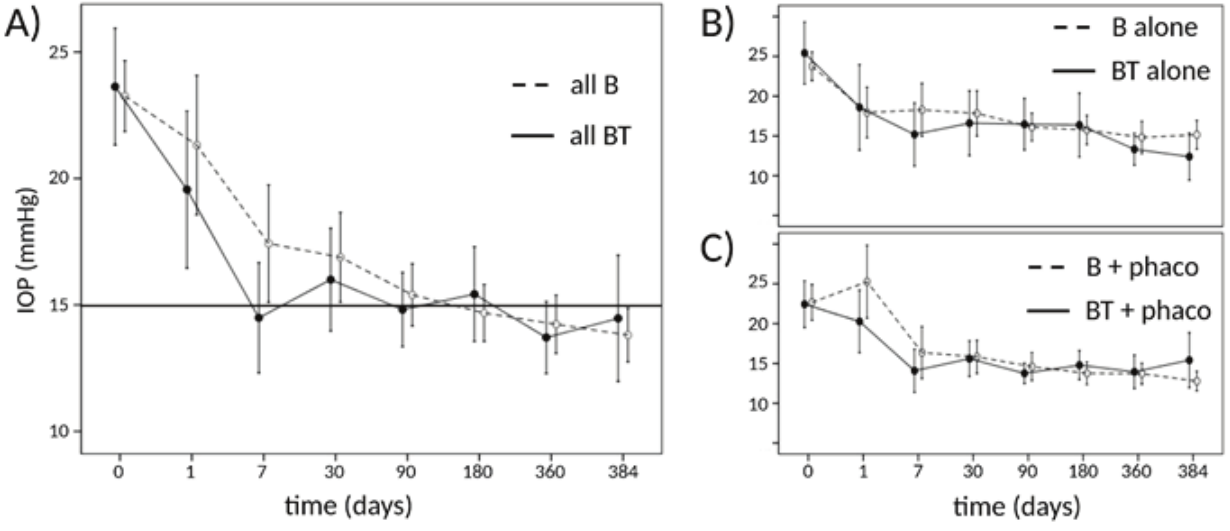
Figure 2. IOP in the B and BT groups. (A) IOP in the BT group was similar to the B group and trended toward a lower average although tubes in the BT group were not fenestrated and trended toward a lower average IOP. (B) B and BT techniques as stand- alone procedures. (C) B + phacoemulsification had a higher IOP on day 1 compared to subsequent IOPs. No such peak was seen in the BT group. Mean ± 95% confidence